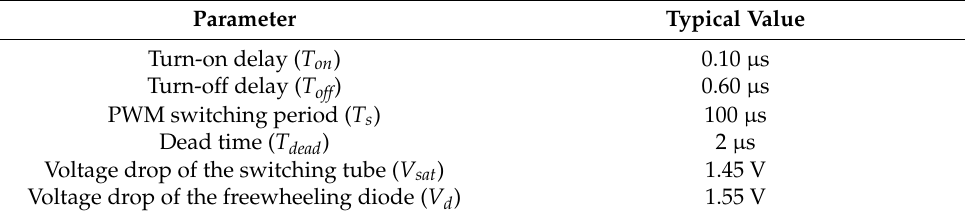
Table 2. Design parameters of employed